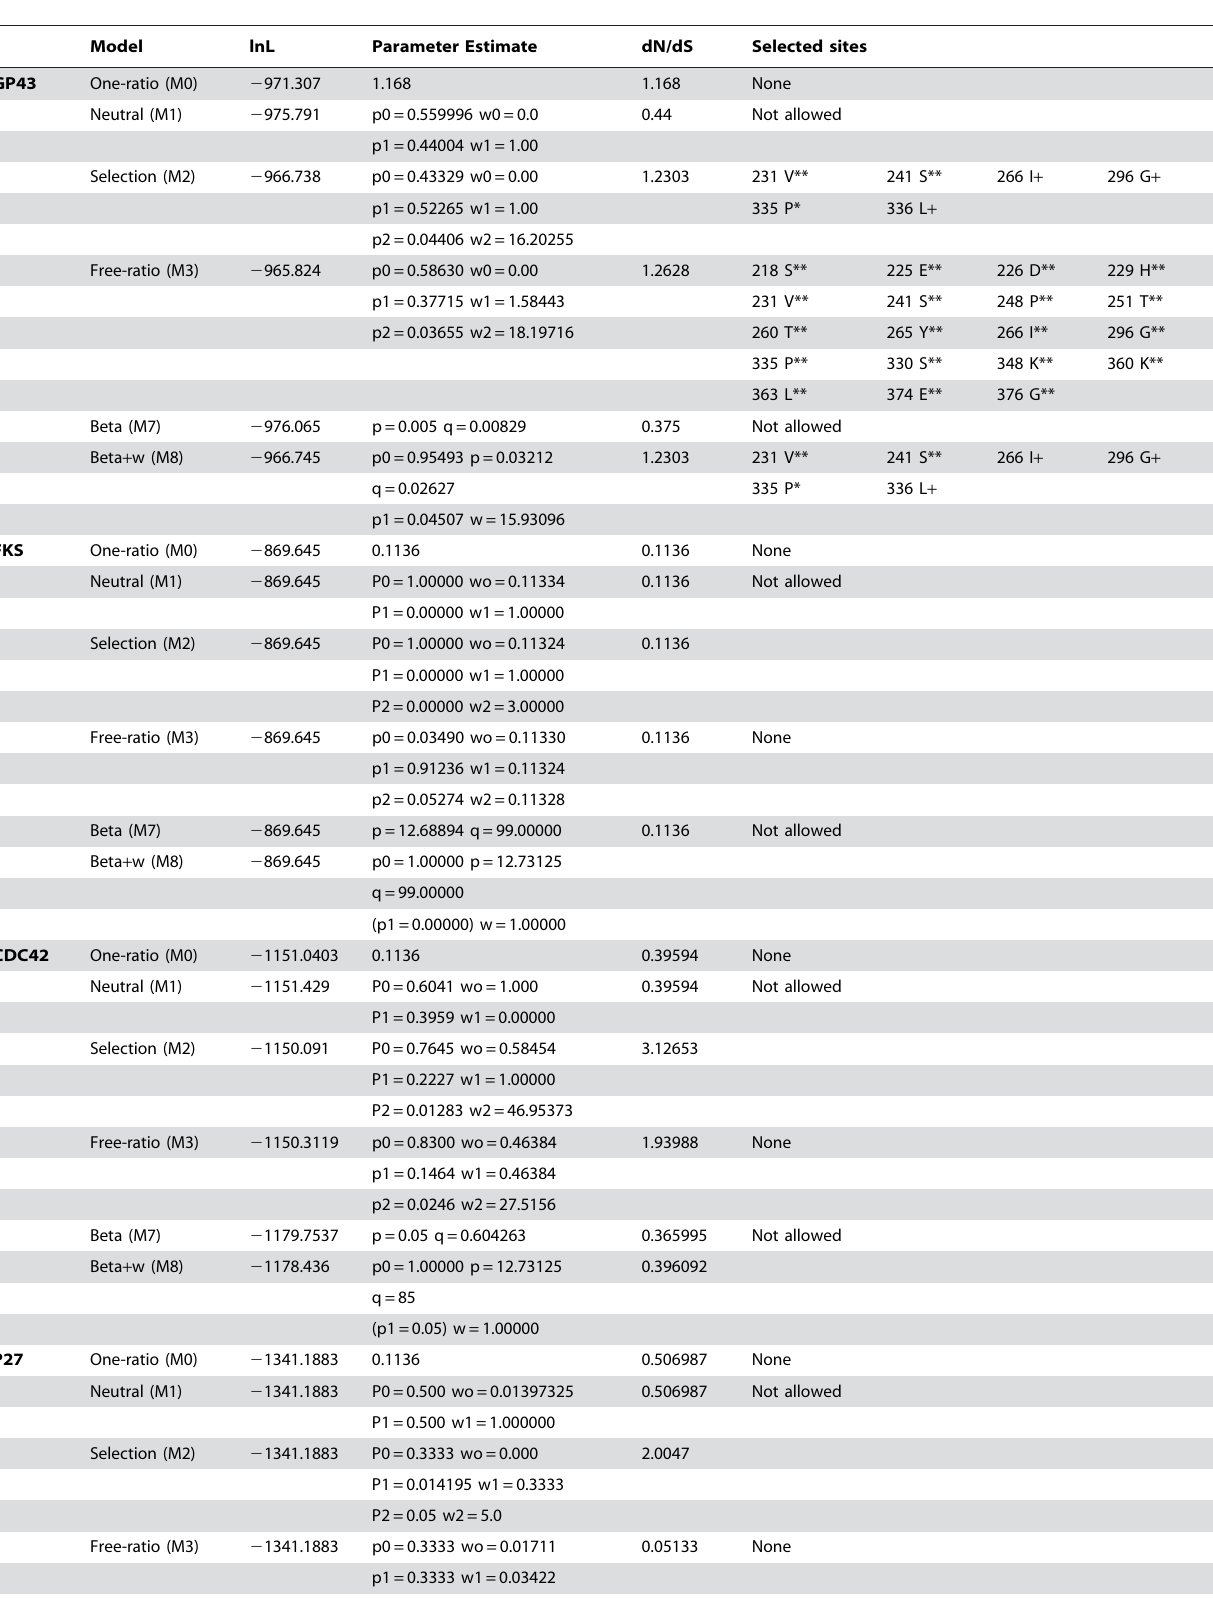
Table 4. Likelihood values, parameter estimates, and sites under positive selection as inferred under the six proposed models applied to each of the four